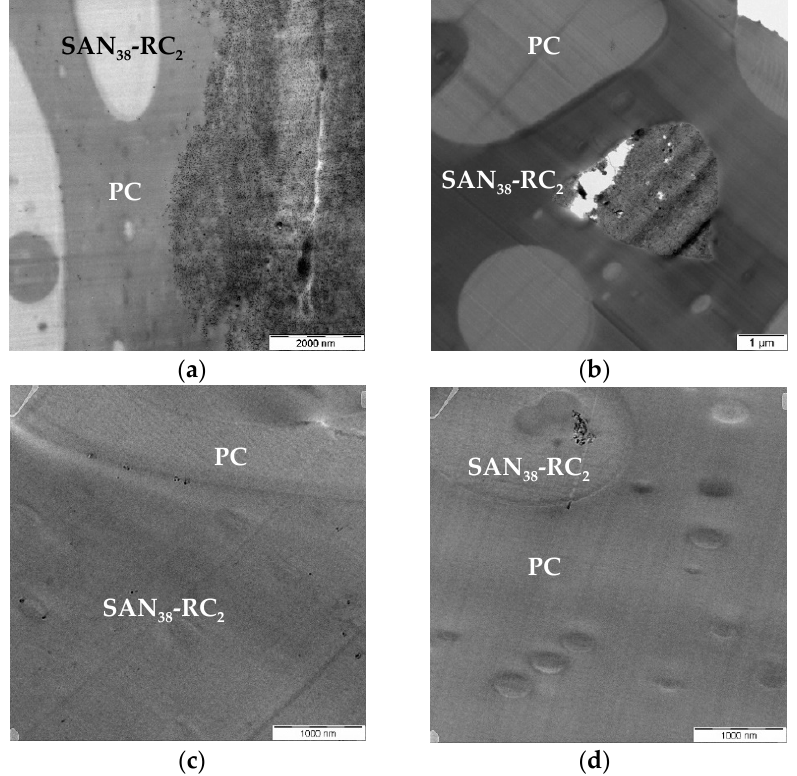
Figure 6. TEM images of PC 60 /SAN 38 -RC 2 blends filled with AP-SWNT and AP-SWNT-NH 2 : ( a , c ) PC 60 /SAN 38 -RC 2 blends showing AP-SWNT (0.5 wt. %) localized in both components with most of the SWCNTs in PC, ( b , d ) in PC 60 /SAN 38 -RC 2 blends AP-SWNT-NH 2 (0.5 wt. %) localized in SAN-RC.